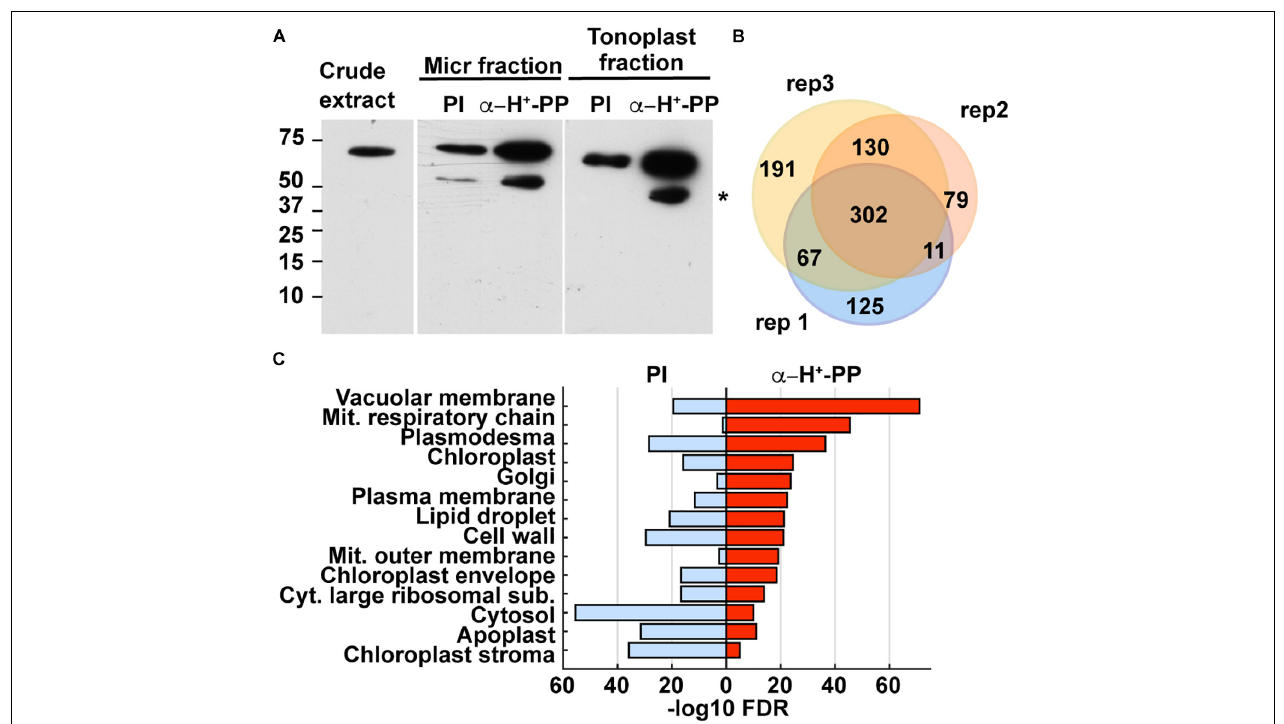
FIGURE 5 | Identification of maize aleurone tonoplast proteins enriched by co-immunoprecipitation (co-IP) with anti-H+-PPase antibodies as shown by immunoblot and proteomic analyses. (A) Immunoblot detection of H+-PPases in maize aleurone crude extract, and immune-precipitated microsomal and tonoplast fractions with either pre-immune serum (PI; negative control) or anti-H+-PPase antibodies. The lower molecular band indicated by an asterisk is likely a degradation product. (B) Venn diagram showing the overlap of proteins detected by MS analysis in the three biological replicates immunoprecipitated with anti-H+-PPase antibodies. (C) Enriched GO terms of proteins from aleurone tonoplast fraction immunoprecipitated with either pre-immune serum (negative control) or anti-H+-PPase antibodies. The GO terms are ranked from top to bottom by their FDR values.